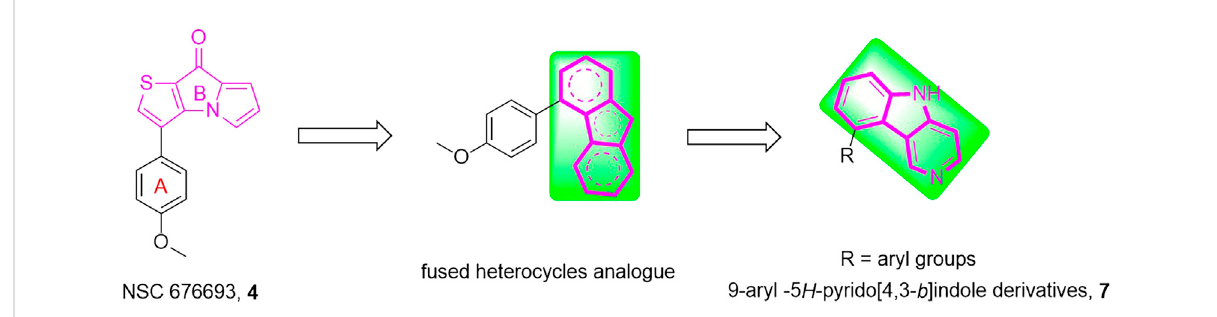
FIGURE 2 The rational design of target compounds.